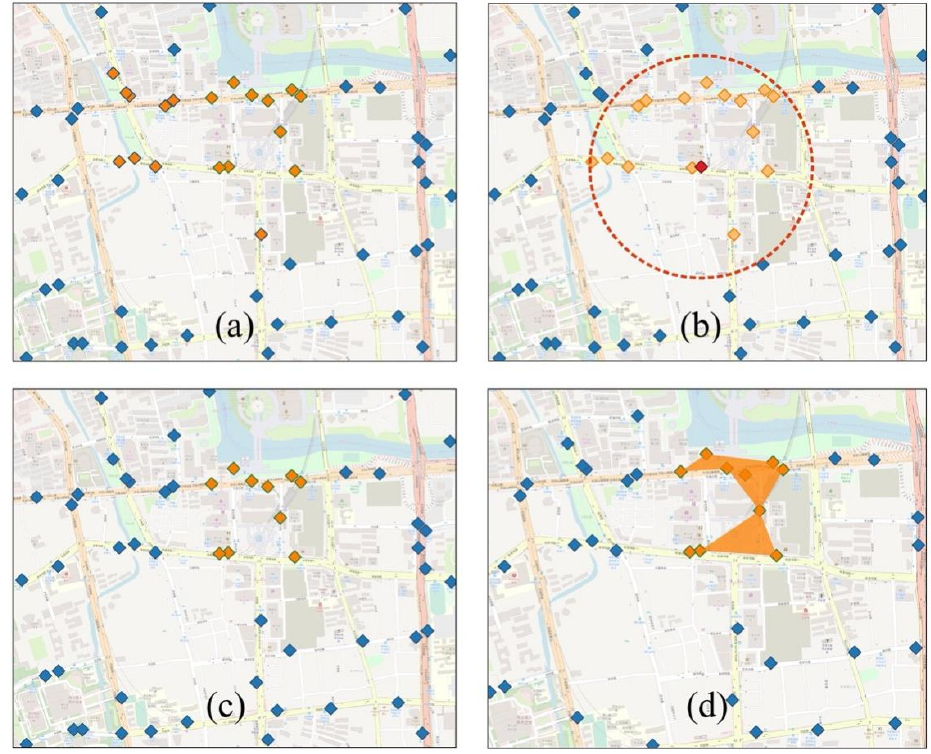
Figure 2. Three-step workflow of demand conflict detection and AOI delineation. ( a ) The results of status calculation; ( b ) spatial filtering process; ( c ) the results after spatial filtering and ( d ) the result imbalance AOI.